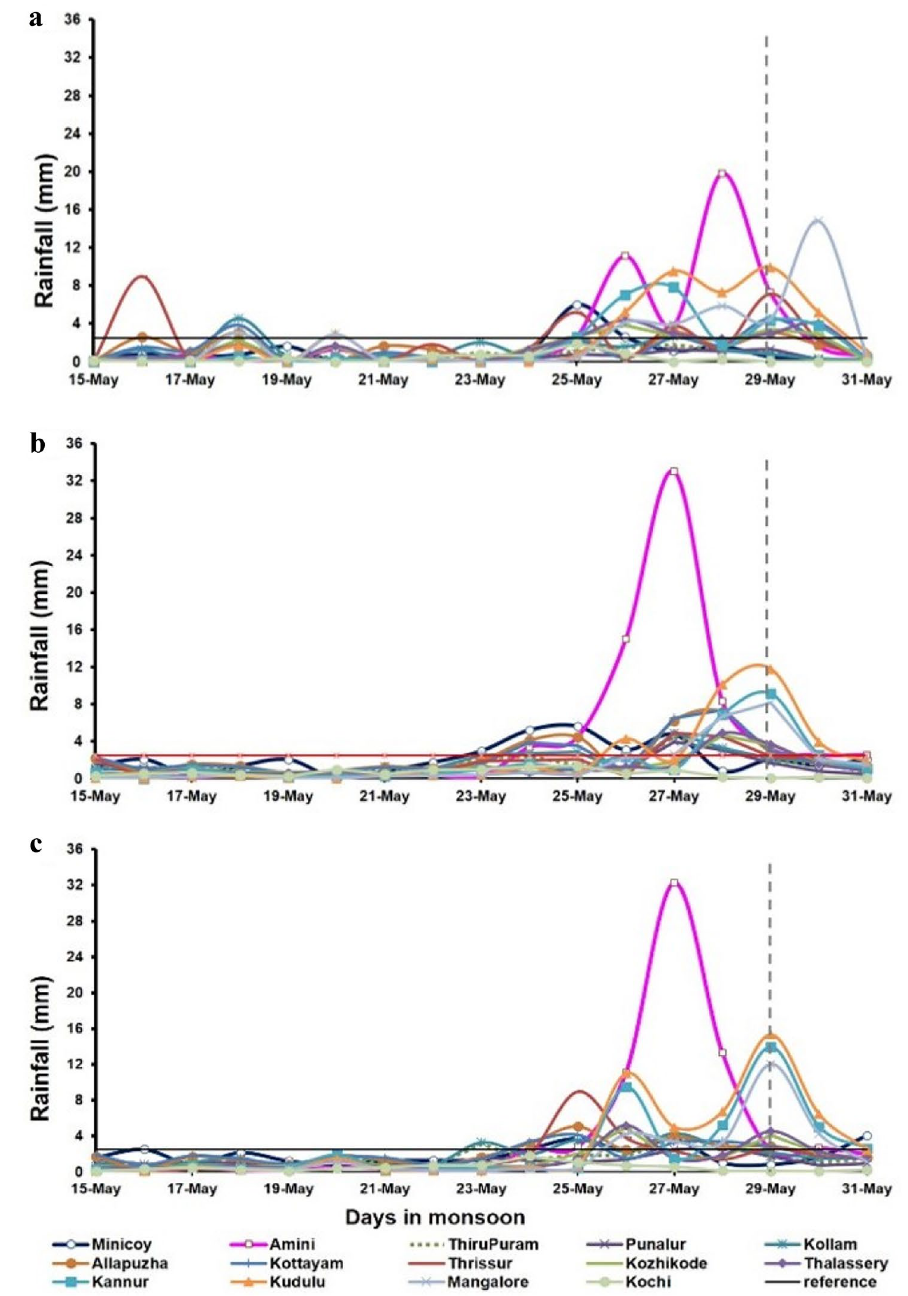
Fig. 2 The time series of rainfall (mm) during 15–31 May 2018 of 14 stations for a observations b NCUM 10-day model forecast, and c UKMO 5-day model forecast. The vertical line indicates the IMD monsoon onset